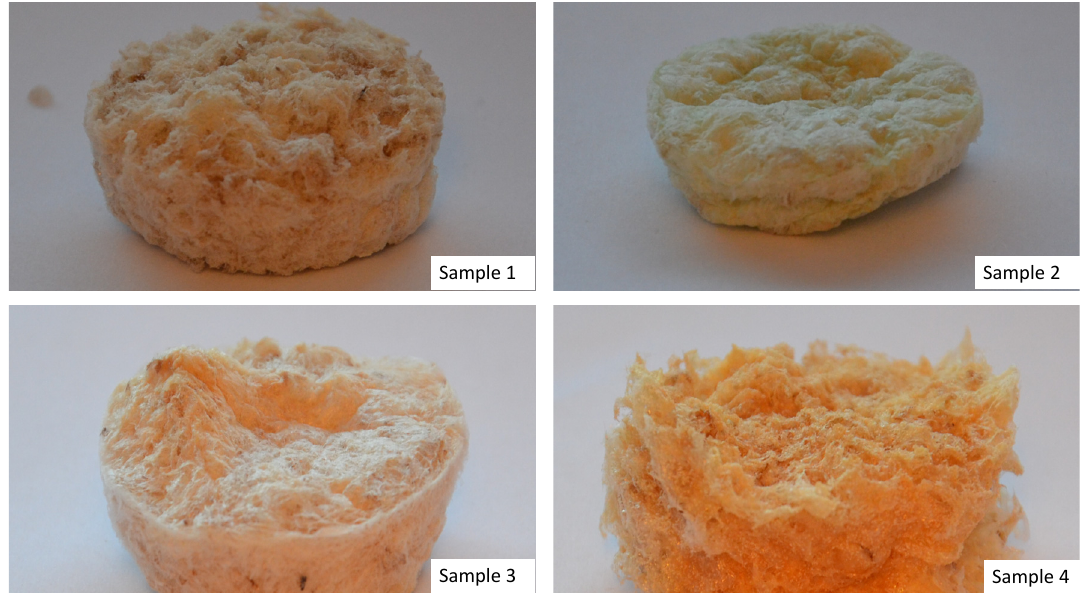
Figure 1. Prepared samples (sample 1—chitosan crosslinked with adipic and malonic acid; sample 2—chitosan crosslinked with adipic and L -glutamic acid; sample 3—chitosan crosslinked with adipic, L -glutamic and malonic acid; sample 4—chitosan crosslinked with adipic and levulinic).